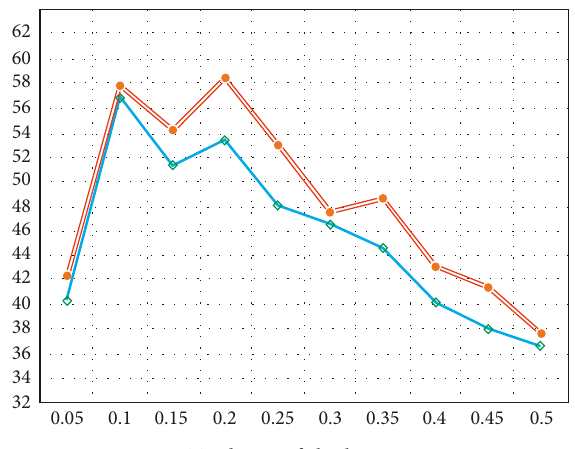
Figure 3: Tendency of the biomass means. Table 1: Comparison of results of different data set before and after using optimization (data set 1).